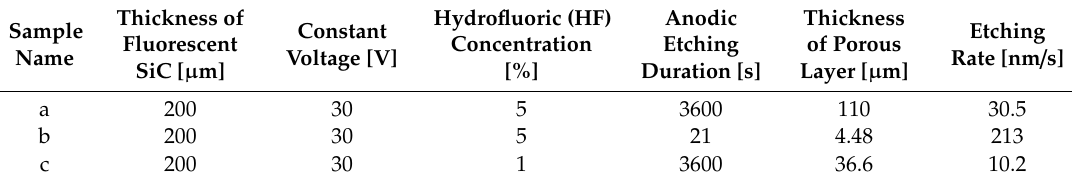
Figure 1. Schematic diagram of the experimental setup for the anodic oxidation process. Table 1. Anodic oxidation conditions for porous samples a, b and c.